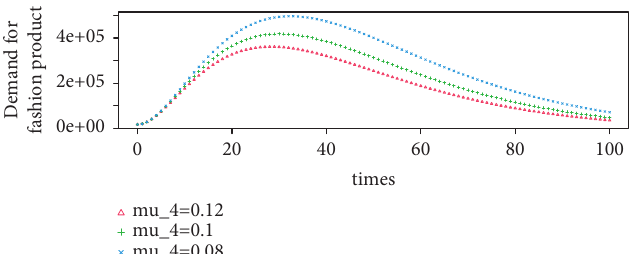
Figure 16: Time series simulation of the demand for fashion product at different rates ( μ 0.12, the demand for fashion products decreases. The curve shifts inward as μ